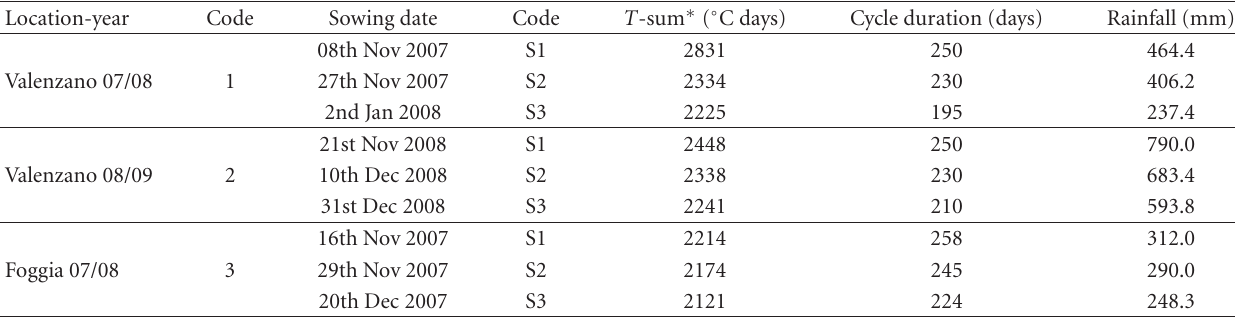
∗ Temperature sums were calculated using a base temperature of 5 ◦ C.